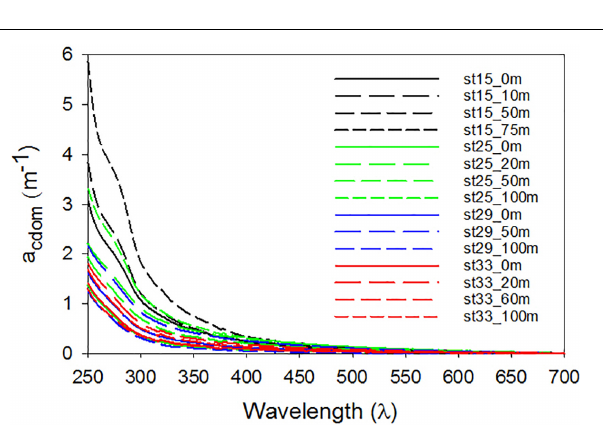
FIGURE 5 | Chromophoric dissolved organic matter (CDOM) spectra. CDOM spectral absorption coefficients between 250–700 nm of samples collected at selected depths for typical stations located along transect T1 (station 33), the SW (sts 15 and 25) and off-RIS (station